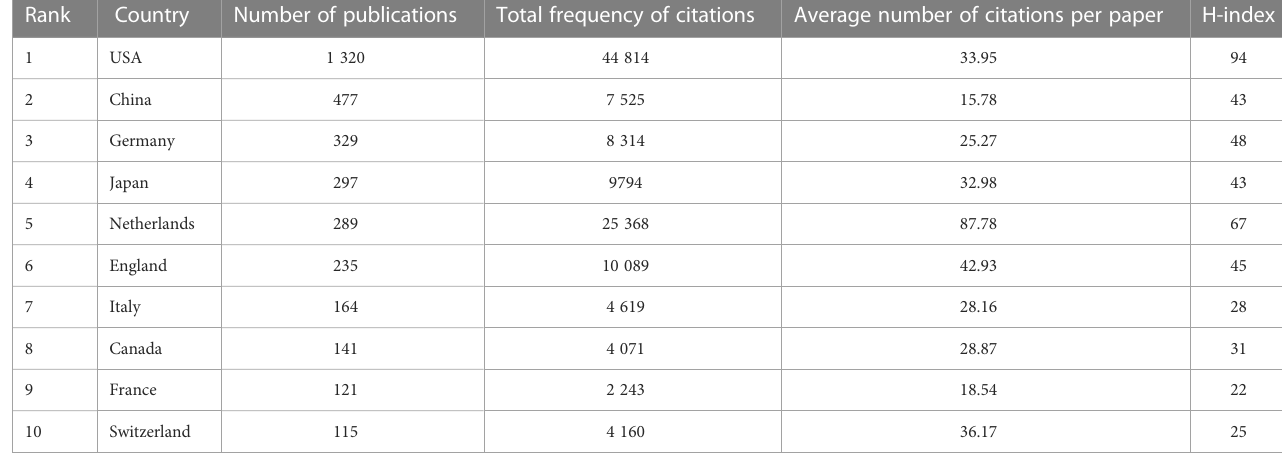
TABLE 1 Publication metrics of articles on tumor organoids of the top ten countries by number of publications. Rank Country Number of publications